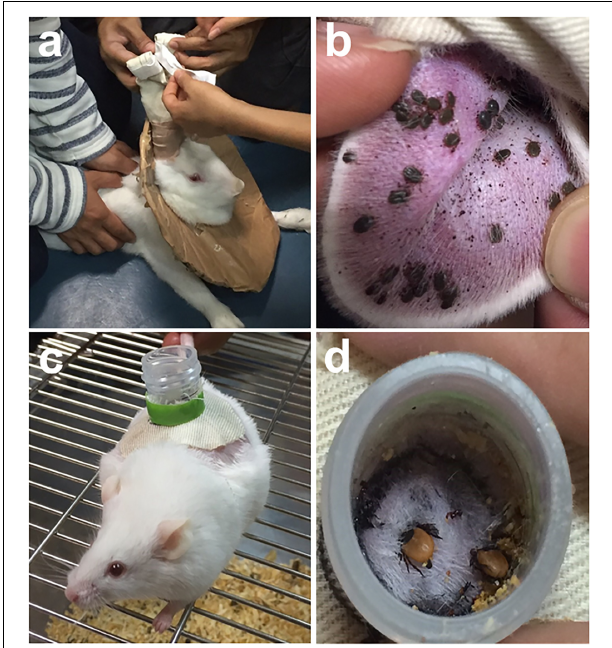
FIGURE 1 | Feedings bags are glued or taped to clean-shaven ears of long-eared rabbit to allow tick engorgement (a) . Haemaphysalis longicornis nymphs infested on a rabbit’s ear (b) . A mouse with a feeding chamber attached on its back (c) . Ixodes persulcatus adult ticks infested on a mouse via chamber feeding (d) . Tick infestation using feeding bags or chamber feeders can be readily utilized to infect ticks with viruses via direct feeding on infected hosts.